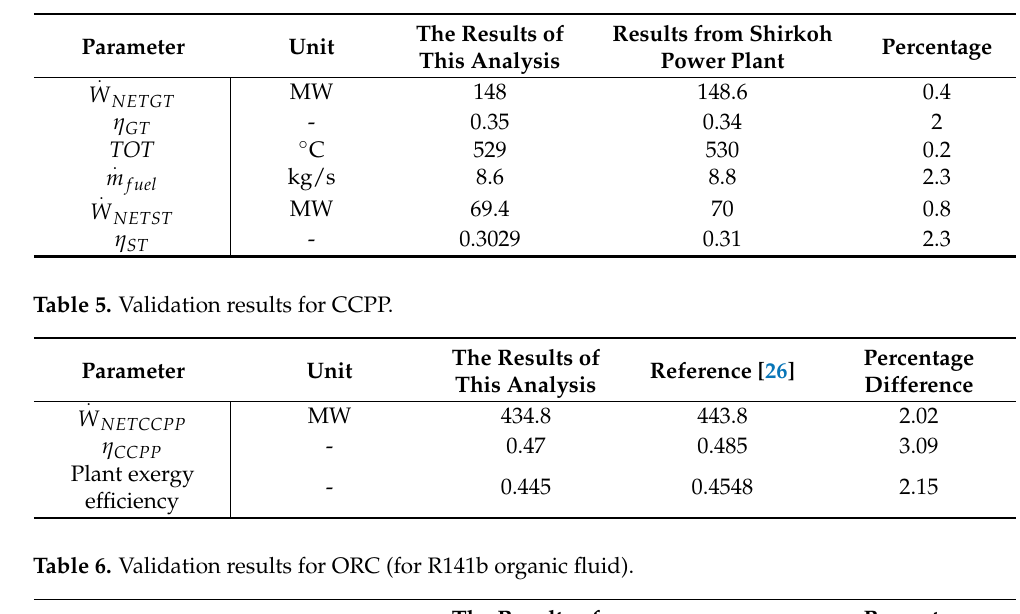
Table 4. Results of the gas turbine and Rankine cycle validation.